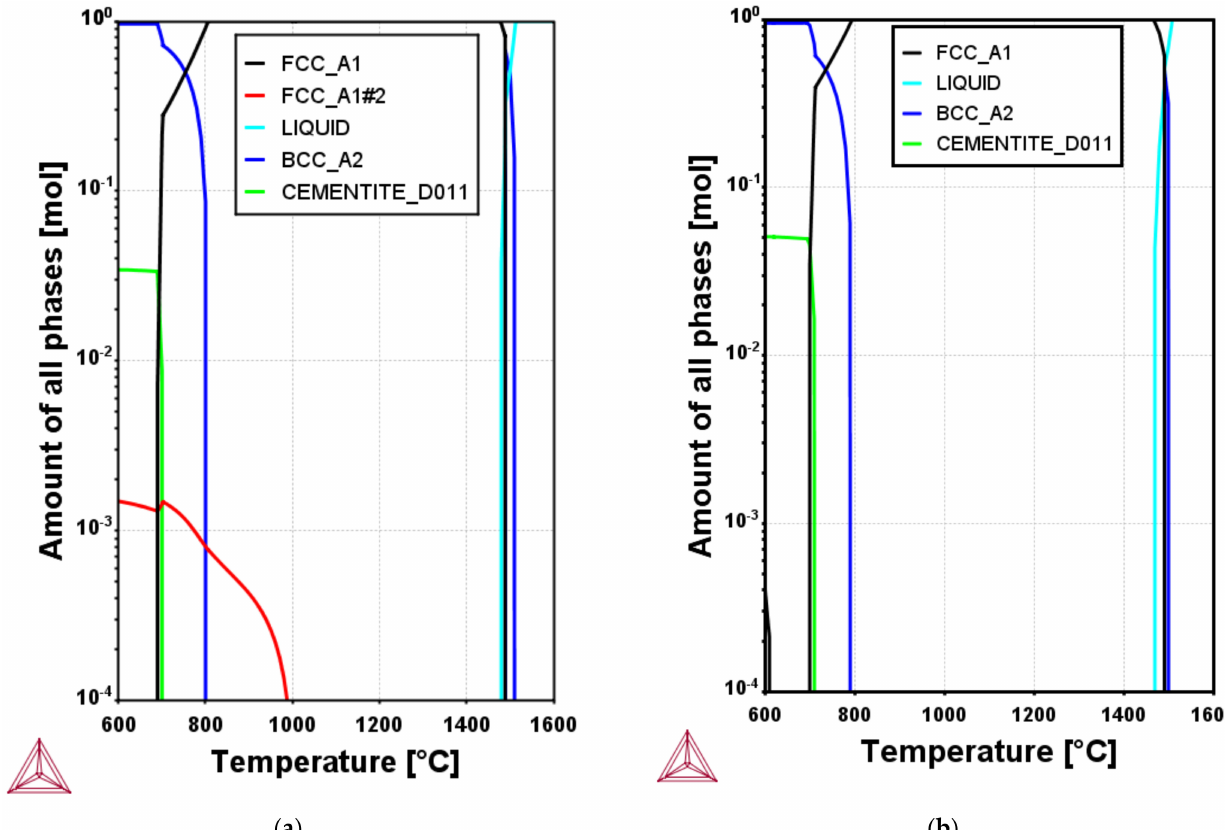
Figure 1. Phase evolutions of the investigated steel grades calculated using ThermoCalc software (TCFE 10 database). The equilibrium amount of all phases vs. temperature for B500B and B400B-R steel grades are shown in ( a ) and ( b ), respectively. FCC_A1, FCC_A1#2 and BCC_A2 phases stand for austenite, V(C,N) and ferrite,